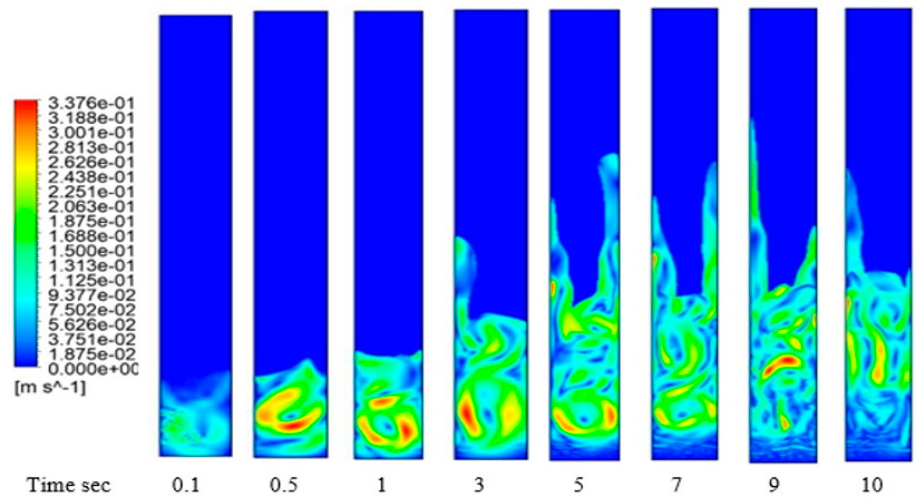
Figure 14. The velocity contour of particles with a diameter of 3 mm with time.